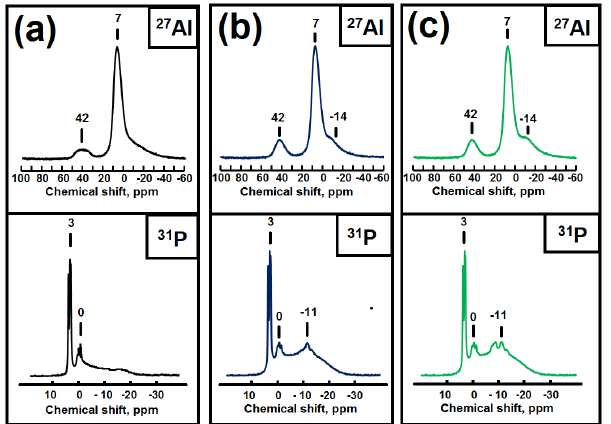
Figure 2. MAS NMR spectra of 27 Al and 31 P initial silicoaluminophosphate gels prepared using various boehmites: ( a ) Sample SAPO-TR(20); ( b ) Sample SAPO-SB(20); ( c ) SAPO-RP(20).